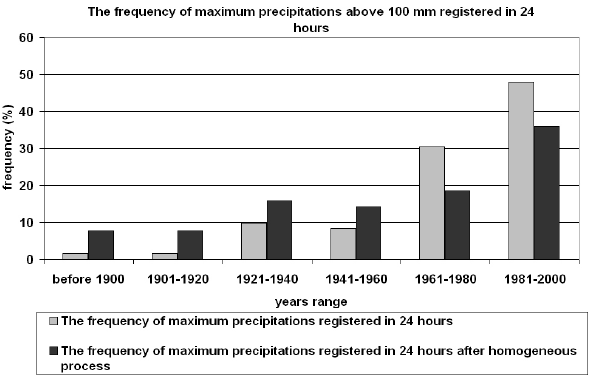
Fig. 4. The frequency of maximum precipitation above 100mm registred in 24 hours.